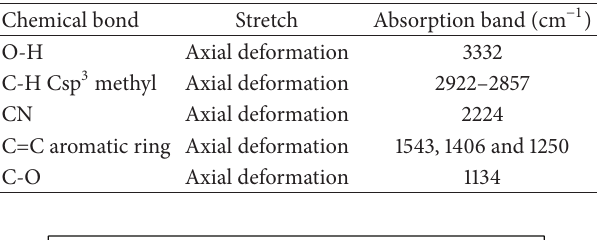
Table 2: Major bands found in the FTIR spectrum of 4-hydroxy- 2,5-dimethylbenzonitrile.